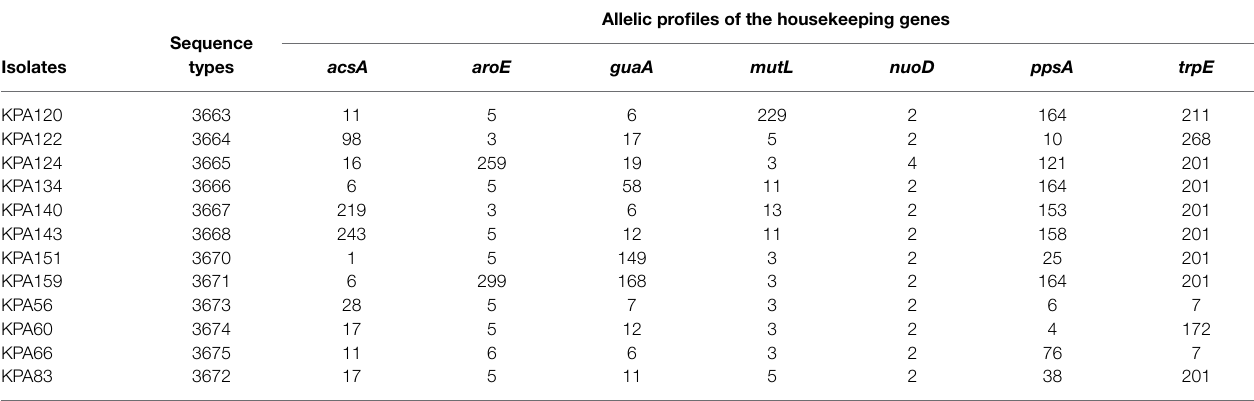
Allelic profiles of the housekeeping